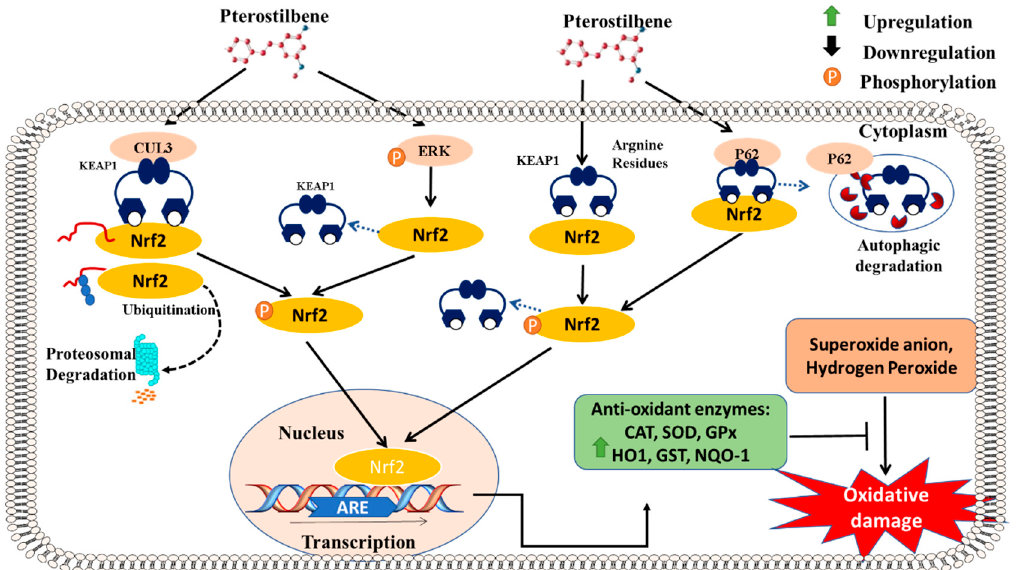
Figure 1. Nrf-2-mediated antioxidant pathway of pterostilbene: Activation and phosphorylation of Nrf-2 signaling is the major mechanism through which the antioxidative response is induced by PTS. Ubiquitination mediated by Cullin-3 (CUL-3) leads to the proteasomal degradation of Nrf-2. PTS inhibits the ubiquitin–proteasome system, thereby increasing the accumulation of Nrf-2. PTS also enables the phosphorylation of Nrf-2, which is critical in the nuclear translocation of the transcription factor. Moreover, PTS phosphorylates and activates the ERK signaling pathway, which mediates the dissociation of Keap-1, resulting in Nrf-2 activation. Furthermore, PTS stimulates the binding of Keap-1 and p62, which enhances the activation of Nrf2. Following its activation and nuclear translocation, Nrf-2 binds to ARE and induces the expression of antioxidant enzymes, which in turn critically attenuate oxidative damage in host cells.